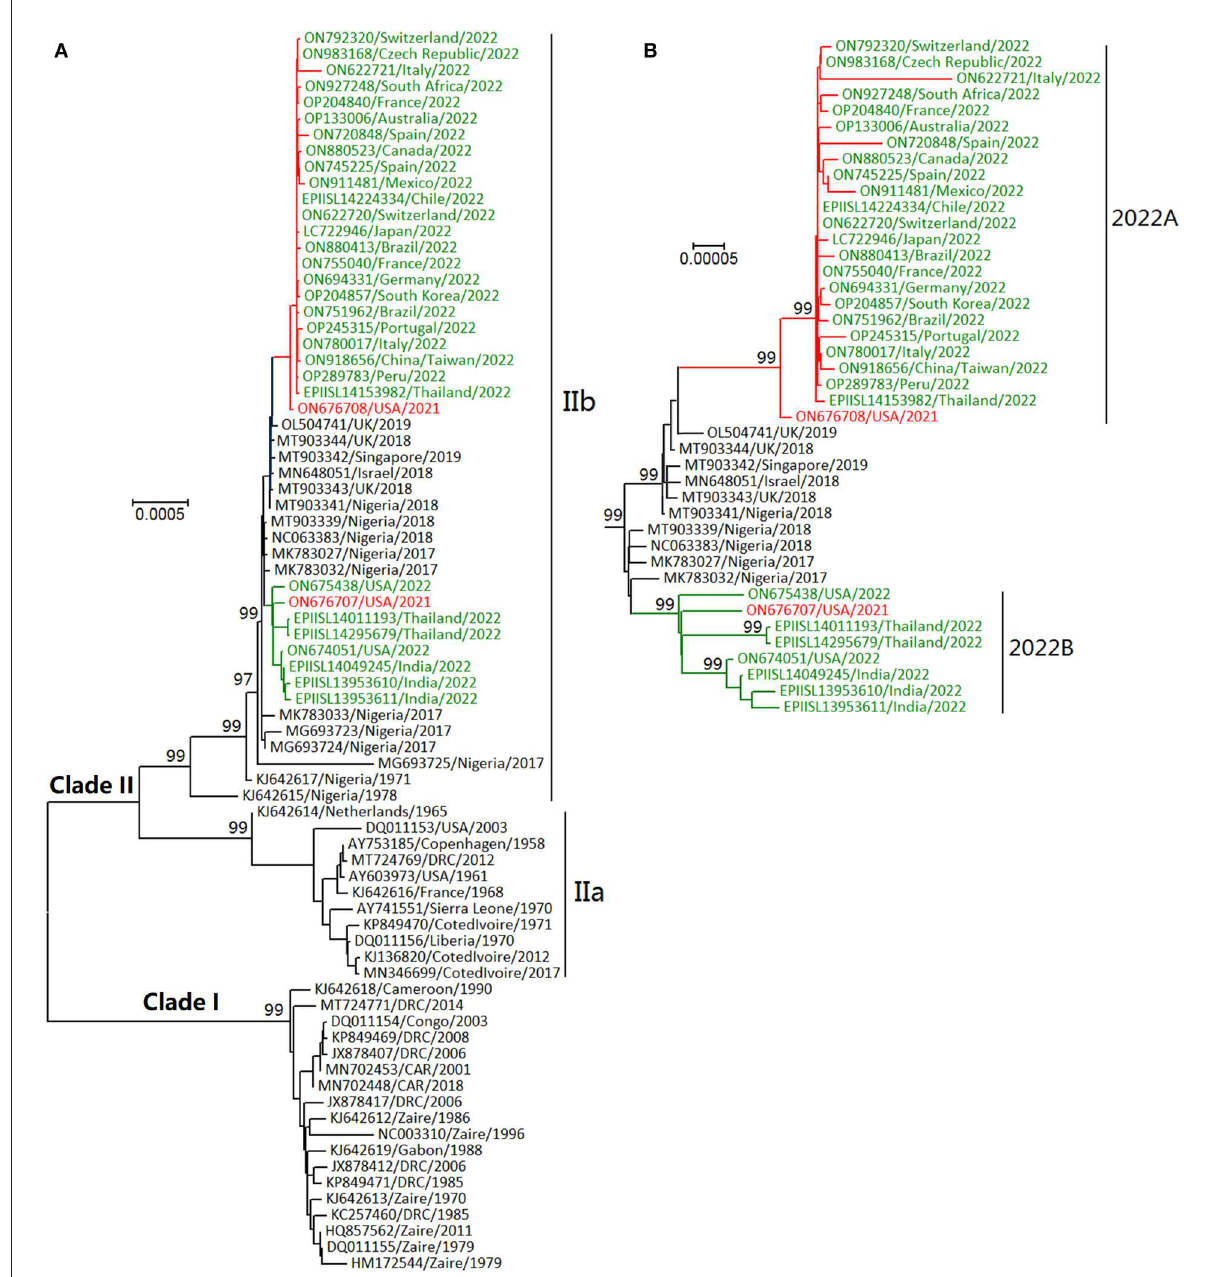
FIGURE2 Phylogenetic relationships of some monkeypox viruses (MPXVs) during the years 1958–2022 (A) and in recent years (B) . Those MPXVs in 2022 shown in green letters were classified into two lineages (2022A and 2022B), which were similar to the two MPXVs detected in the USA in 2021 shown in red